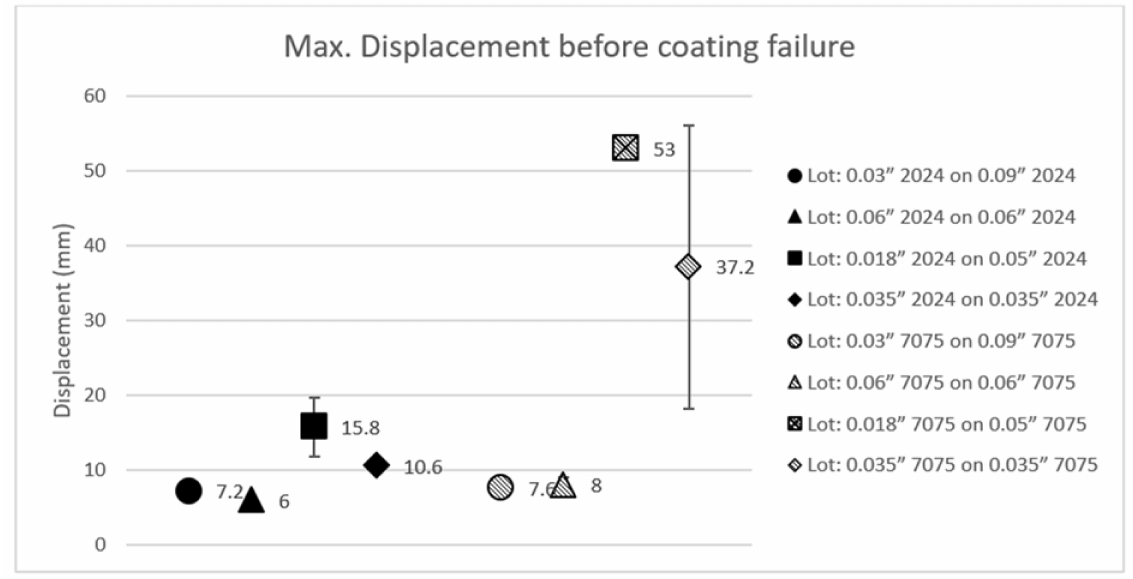
Figure 15. Averaged maximum displacement from the horizontal plane before coating failure.